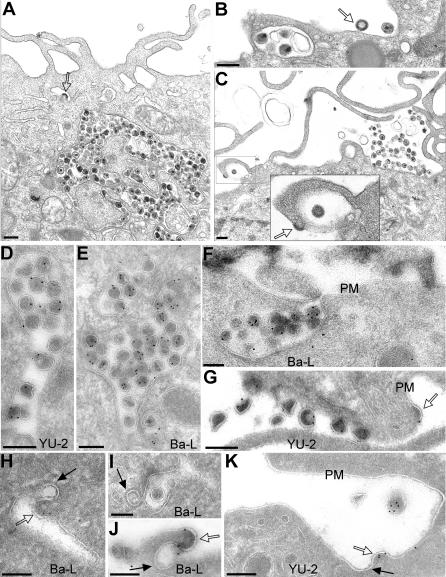
A Gallery of Primary Human MDM Infected with HIV-1 Strains YU-2 and Ba-LCells were infected with HIV-1 strain Ba-L (A–C, E, F, and H–J) or YU-2 (D, G, and K).(A–C) Shows plastic-embedded sections displaying extra- and seemingly intracellular virions and budding profiles (open arrows).(D–K) Thawed cryo-sections were labeled with anti-capsid followed by 10 nm (D–G, J, and K) or 5 nm (H and I) protein A gold.(D and E) Labeled virions accumulated inside vacuolar structures.(F) Labeled virions in a plasma membrane invagination that is directly connected to the extracellular space.(G) A virus-budding profile (open arrow) and several virus particles on the plasma membrane.(H) A virus-budding profile (open arrow) next to a structure resembling a clathrin-coated pit (arrow) inside a vacuolar structure.(I) A virus-containing vacuole with a structure resembling a clathrin-coated pit (arrow).(J and K) Virus-budding profiles (open arrows) next to structures resembling clathrin-coated pits (arrows) on the cell surface. PM, plasma membrane. Bar, 200 nm.